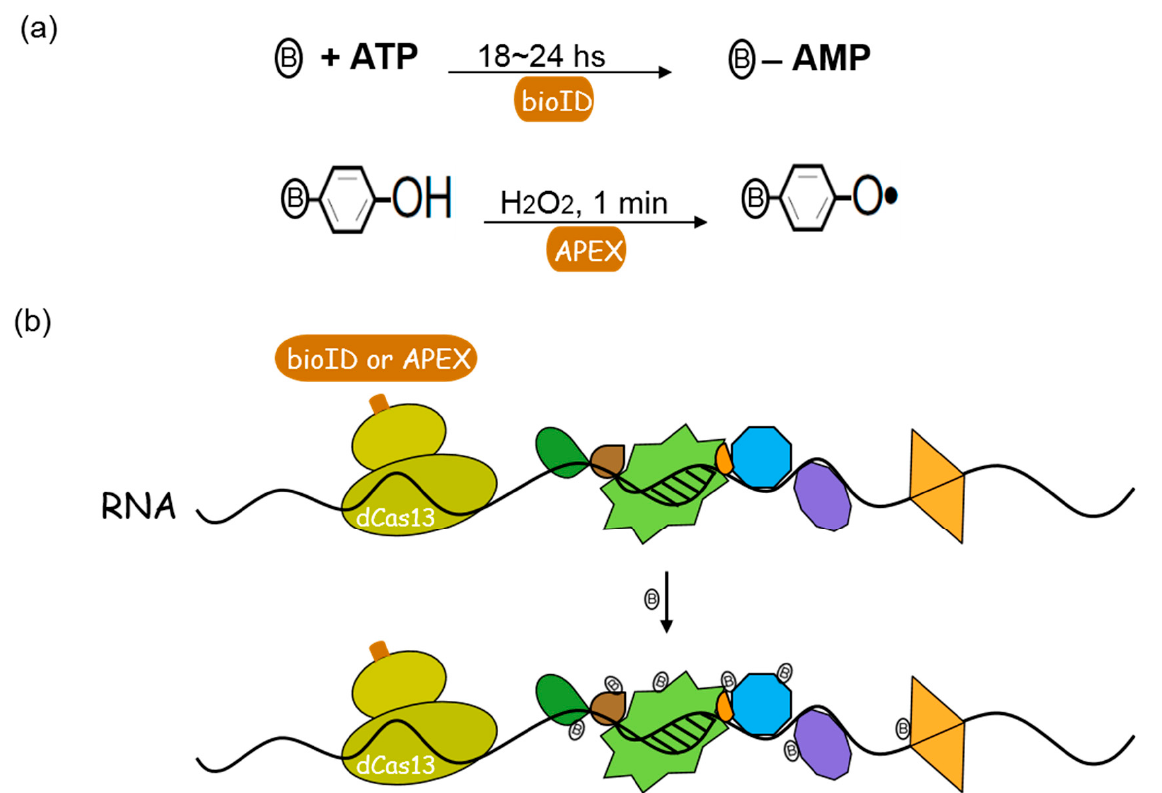
Figure 1. Schematic representation of CRISPR-dCas13-guided proximity labeling. ( a ) Proximity labeling reaction with bioID or APEX. BioID utilizes the supplied free biotin and endogenous ATP to convert biotin to bioAMP radicals, which react with lysine residues on proximate proteins. This reaction usually requires 18~24 h to obtain enough biotinylation materials for quantitative proteomics. Peroxidase-based APEX or APEX2 oxidizes biotin-phenol into massive short-lived biotin-phenoxyl radicals that react with proximate proteins in electron-rich amino acid side chains under the addition of hydrogen peroxide. ( b ) RNA-targeting CRISPR-dCas13-mediated proximity labeling. Catalytically inactivated CRISPR-Cas13 (dCas13) fused with proximity labeling enzyme bioID or APEX, dCas13 fusion protein was directed by CRISPR to target RNA of interest and biotinylate proteins proximal to the RNA in living